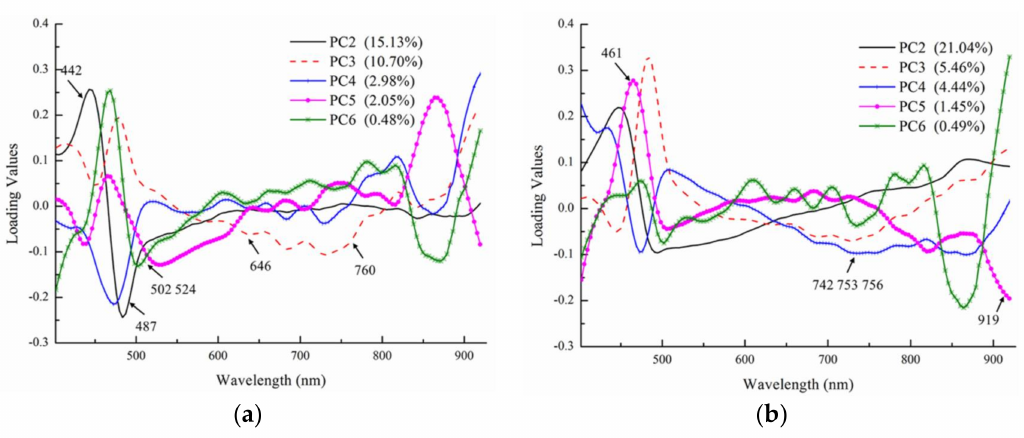
Figure 8. ( a ) Loading line plot of A. flavus and ( b ) loading line plot of A.